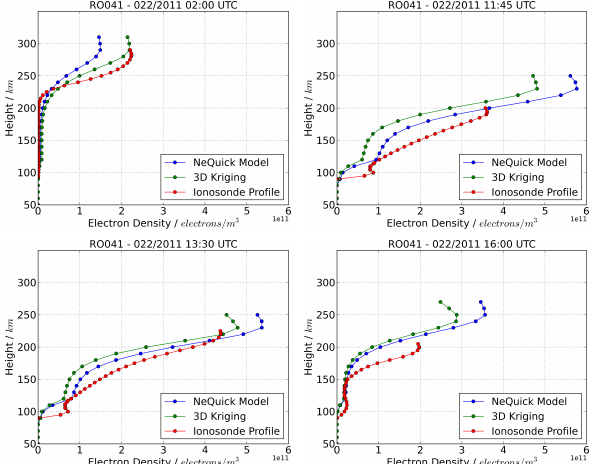
Figure 6. Comparison of the NeQuick electron density profile (blue), the reconstructed electron density profile (green) and the ionosonde profile (red) of the ionosonde station RO041 on DOY 22 (2011) at 02:00, 11:45, 13:30 and 16:00UTC.